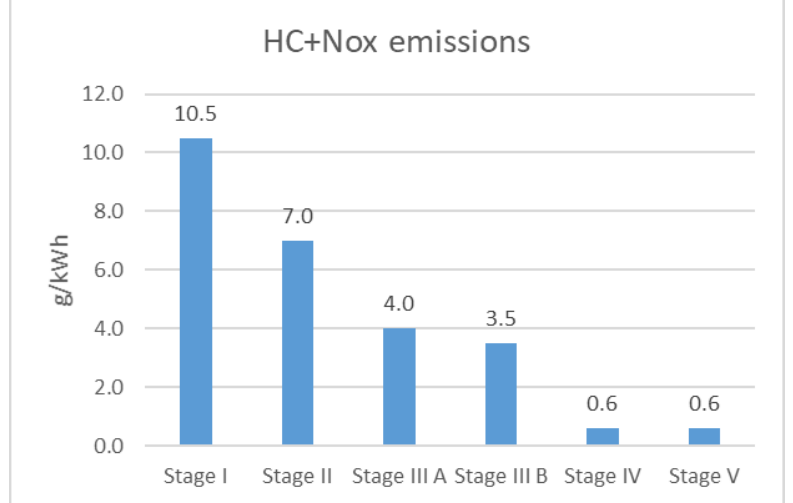
Figure 1. Evolution of NOx + HC emissions standards.